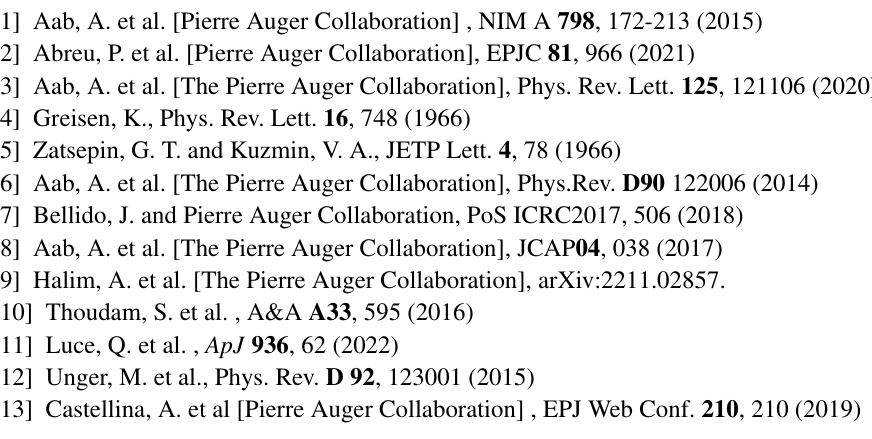
source region, thereby generating a pile-up of nucleons with energy scaling as 1 / A , being